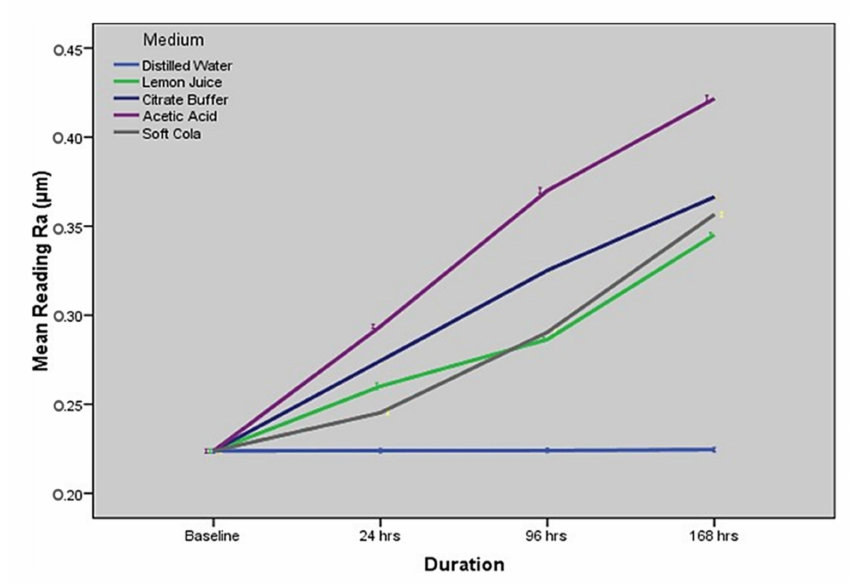
Figure 3. Comparison of surface roughness (mean Ra with standard error) across four different time intervals for each of the five immersion